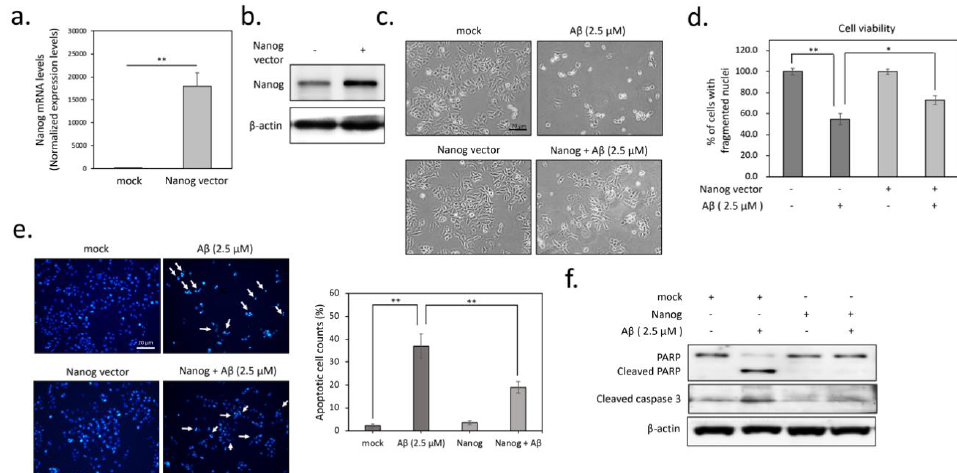
Figure 1. Overexpression of Nanog suppresses A β -induced apoptosis in human neuronal cells (SK-N-MC). Quantification of Nanog expression using real-time PCR ( a ) and western blot ( b ). At 24 h post-transfection, both mRNA and protein levels of Nanog were significantly upregulated, indicating the successful overexpression of Nanog; ( c ) treatment with 2.5 µ M of A β 1–42 for 24 h markedly induced morphologic changes and cell death and overexpression of Nanog prevented these e ff ects by A β ; ( d ) tetrazolium salt methyl-thiazol-tetrazolium (MTT) assays demonstrated that overexpression of Nanog significantly protected against A β -induced cytotoxicity; ( e ) overexpression of Nanog markedly reduced A β -induced nucleus fragmentation, determined using 4’,6-diamidino-2-phenylindole (DAPI) staining. The percentage of apoptotic cells was calculated from five random fields; ( f ) western blotting results revealed that overexpression of Nanog inhibited A β -induced caspase-3 and polymerase (PARP) cleavages, two hallmarks of apoptosis. Values were expressed as means ± SEM from at least three independent experiments. The significance of di ff erences was determined through unpaired Student’s t- test or multiple comparisons with Dunnett’s post hoc test at * p < 0.05 and ** p < 0.01 compared with the indicated groups. Scale bar represents 20 μm.